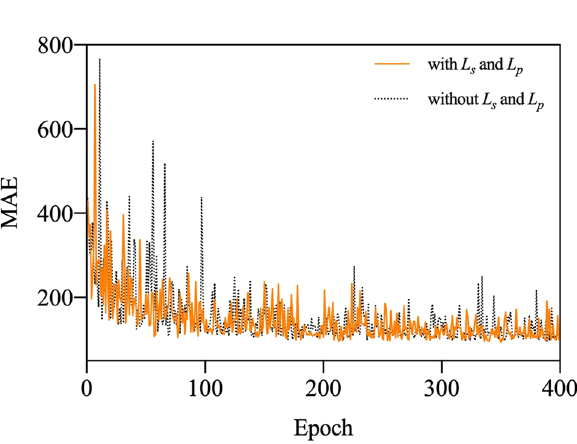
Figure 7. Training curves of ODConv and DConv on the UCF-QNRF. The training process with L s and L p is indicated by the orange solid line, and another gray dotted line presents the training process without L s and L p